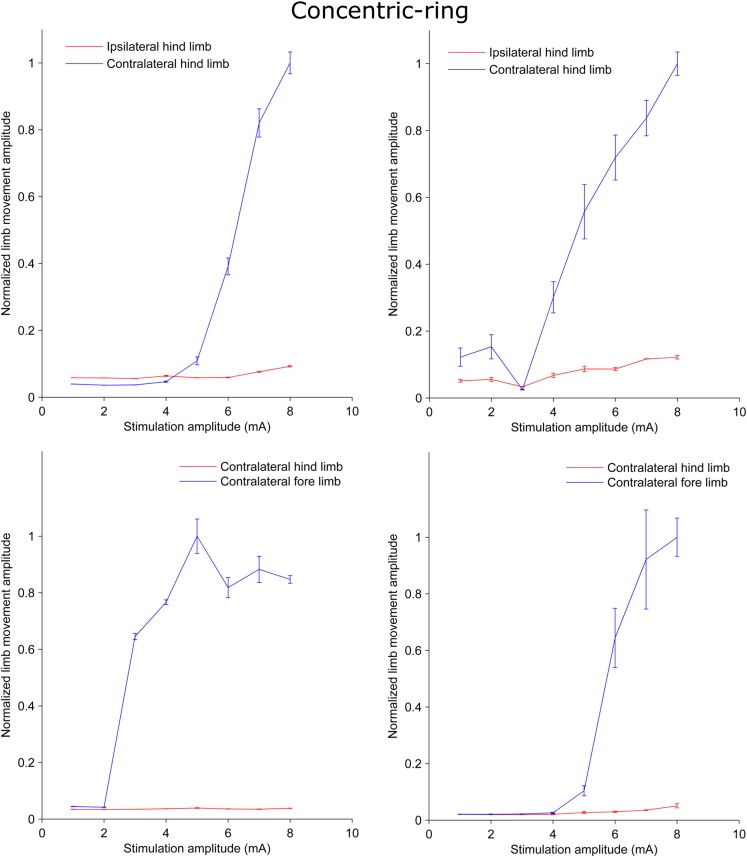
Plots from rat experiments showing the limb movement amplitude as a function of stimulation amplitude applied to concentric-ring ECS electrode placed over the rat motor cortex. The upper panel compares the movement in the hind limbs while the lower panel compares the movement in the hind limb to that in the fore limb. Error bars represent the standard deviation. When stimulation targeted one of the hind limbs and the amplitude was below threshold (upper panel), both the hind limbs ipsilateral (red) and contralateral (blue) to the side of stimulation showed no increase in the movement amplitude. However, when stimulation amplitude was increased above threshold there was significant increase in the contralateral limb movement and no, or relatively low, ipsilateral movement. Similar results were obtained in the lower panel. However, this time stimulation targeted the fore limb cortical area. Movement was detected in the contralateral fore limb (blue) but not in the contralateral hind limb (red). This indicates that concentric-ring ECS can cause selective stimulation of the rat motor cortex.